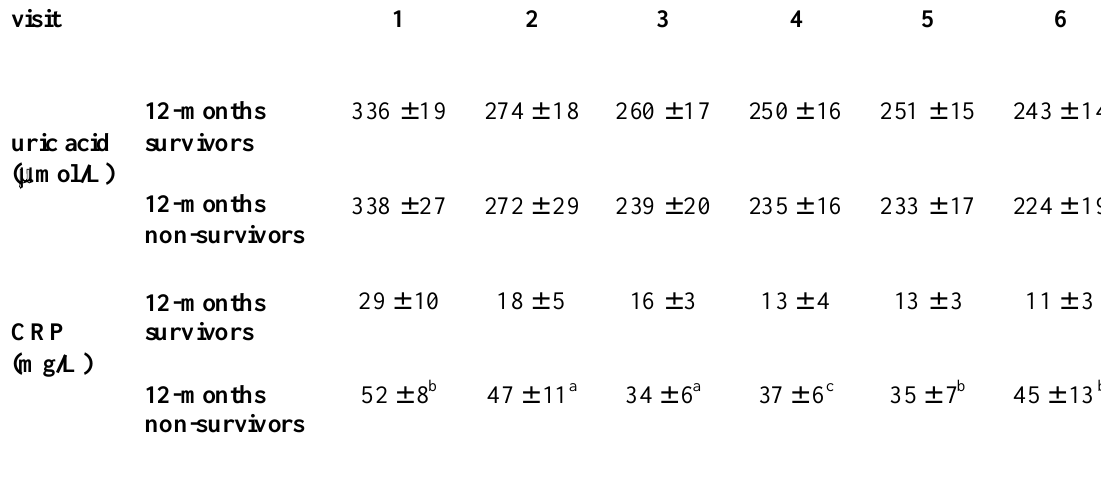
Table 1.: Serum uric acid and C-reactive protein in patients who survived more or less than 12 months.Shown is the mean – standard error of the mean. a p < 0.01; b p < 0.001 and c p < 0.0001 compared to 12-months